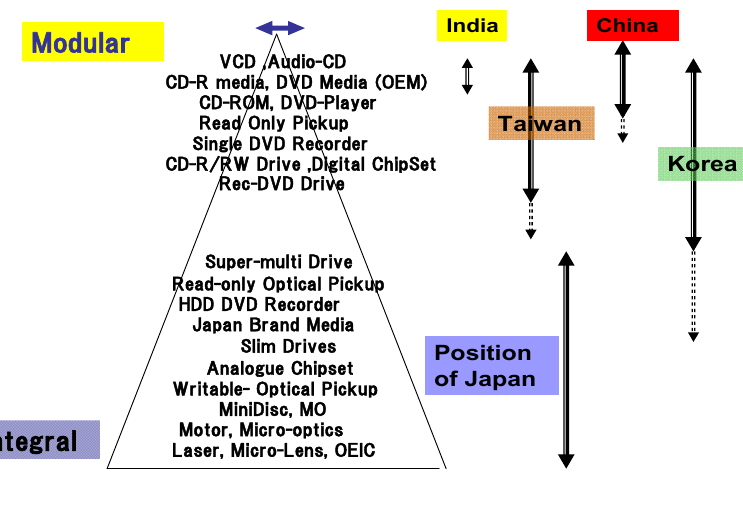
Figure 7. Position of China/Taiwan, Korea and Japan in Product Architecture of CD/DVD Families